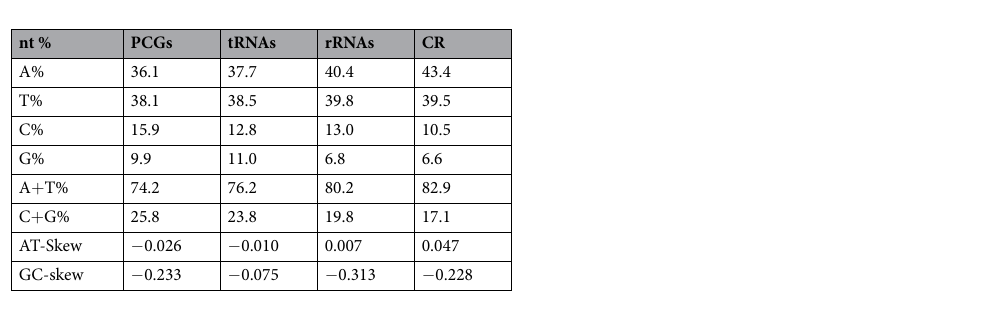
Table 5. Composition and skewness of Clistocoeloma sinensis mitogenome. CR = control